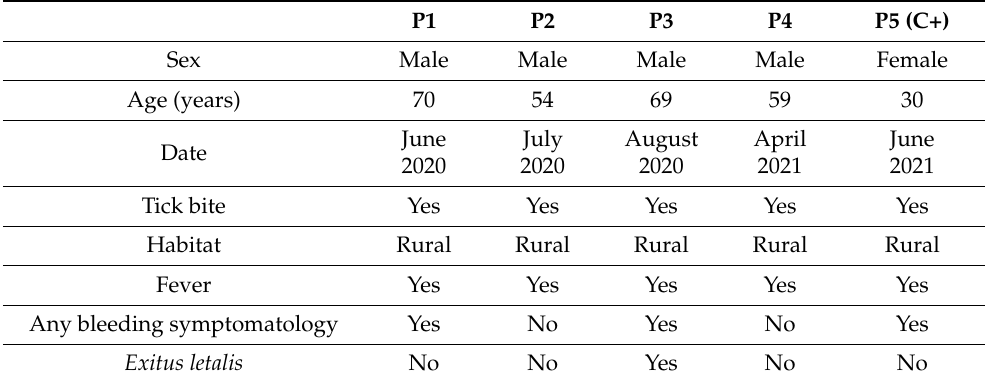
Table 1. Main data of Crimean–Congo haemorrhagic fever patients included in this study. P1–P5, patient samples; C+, positive